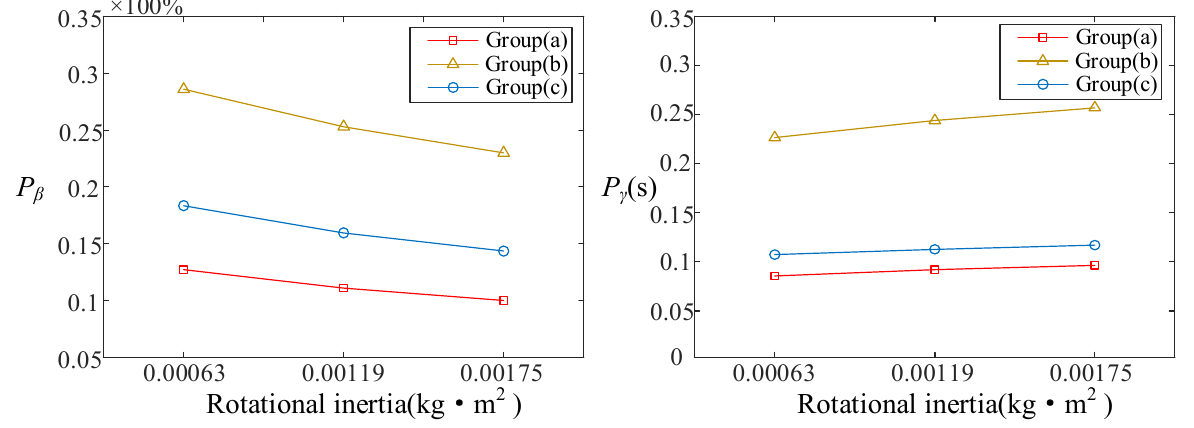
Figure 14. Comparison of the parameters 𝑃